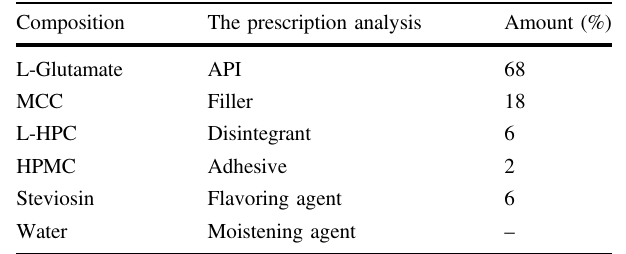
Table 8 The parameter of extrusion-spheronization process